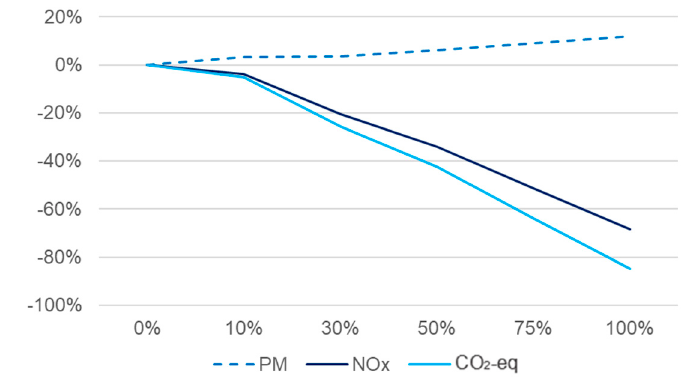
Figure 19. Expected yearly emission development through e-mobility.